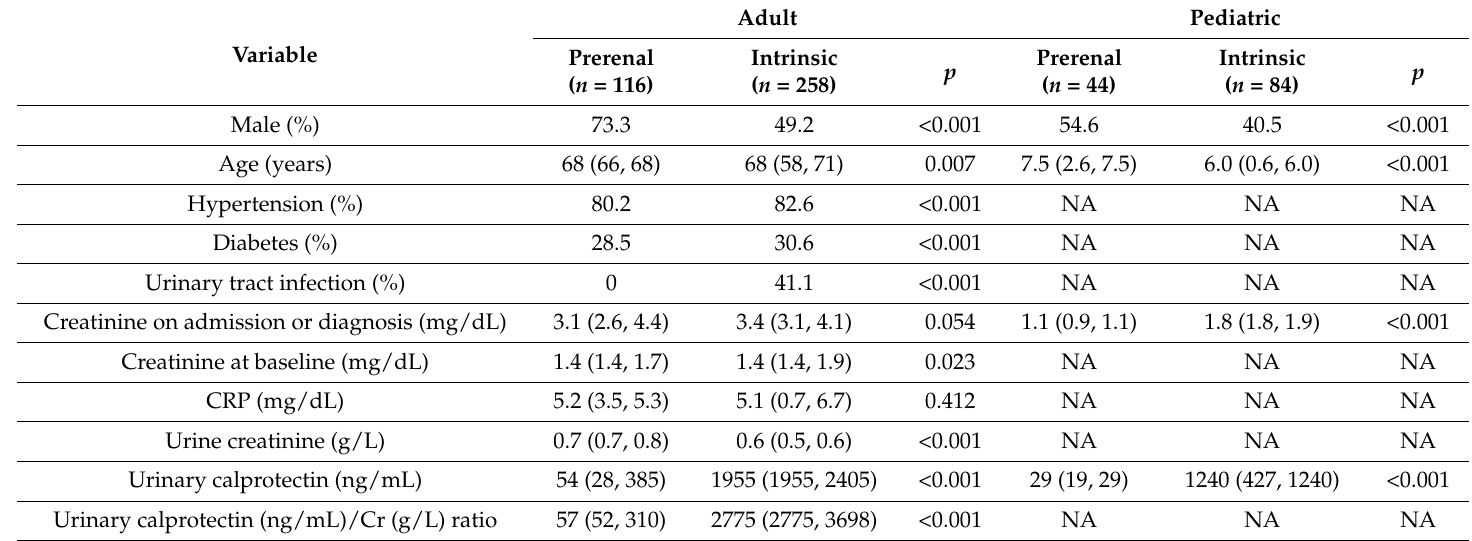
Table 2. Patient characteristics based on available data.